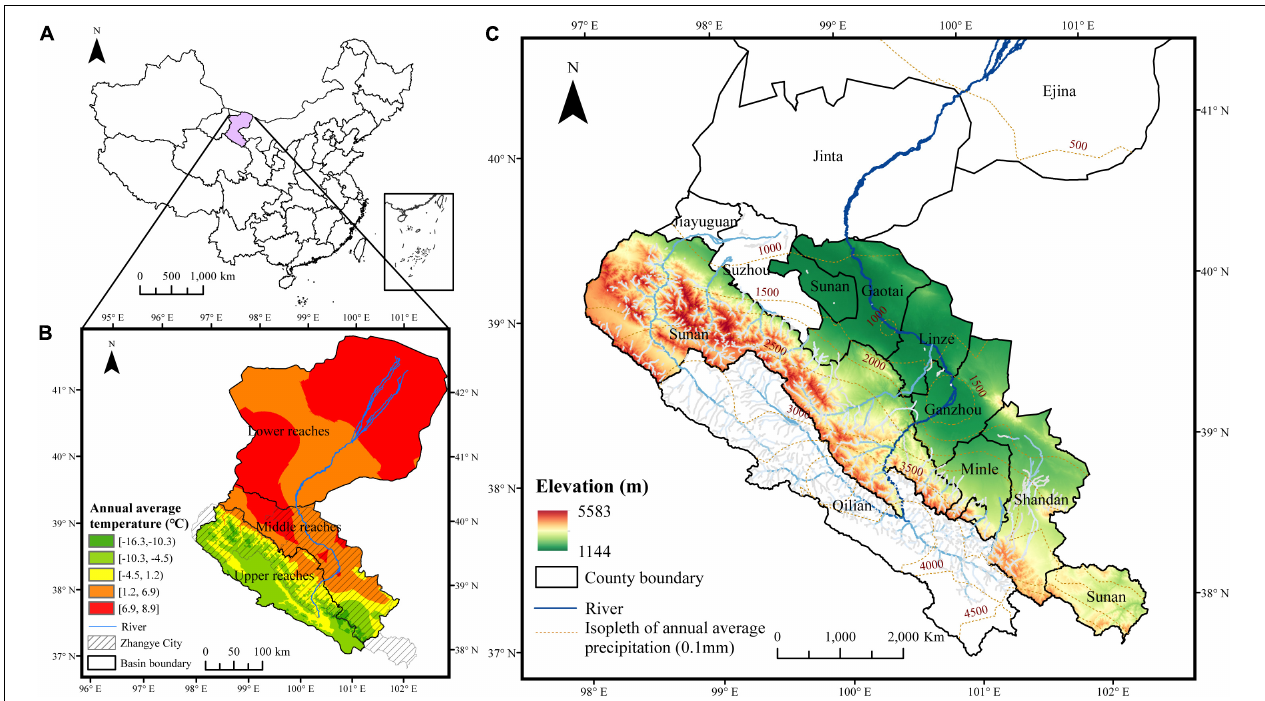
FIGURE 1 | Geographical location of Zhangye in the HRB, northwestern China. (A) The map of China. (B) The location of the Heihe River Basin. (C) The location of Zhangye